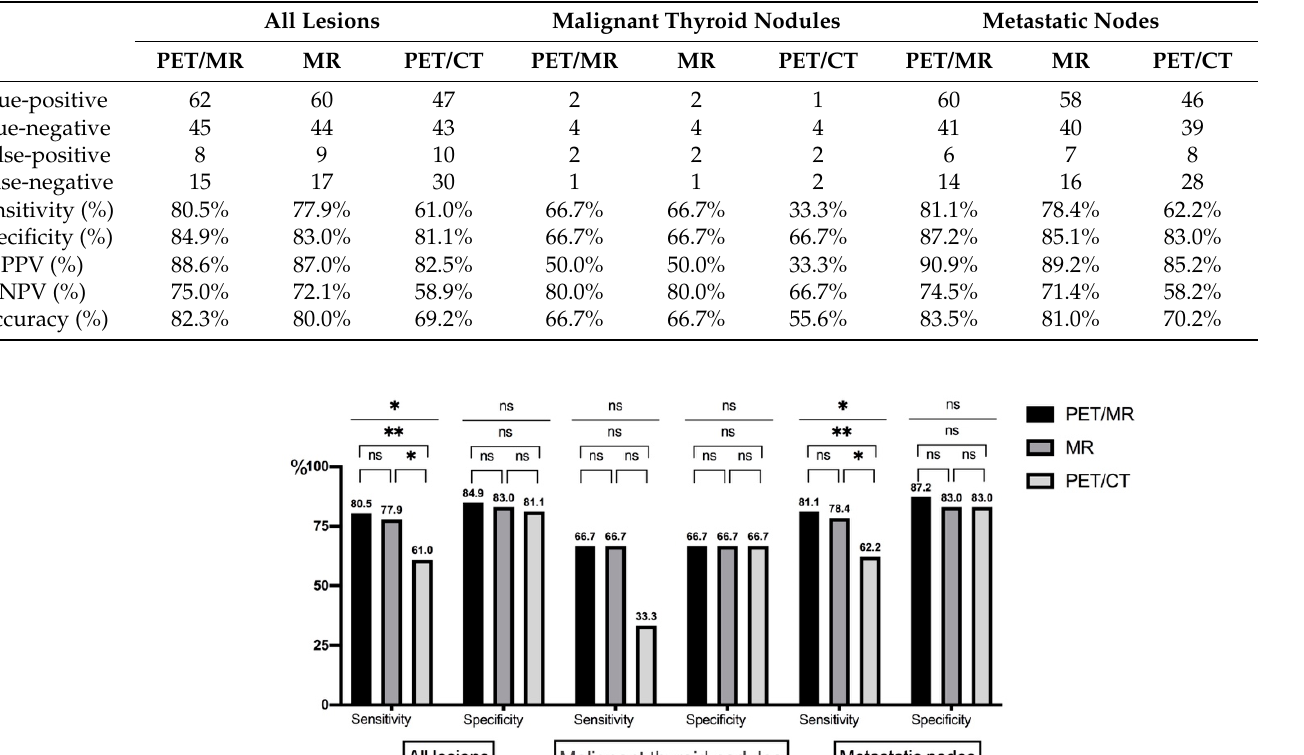
Table 3. Diagnostic performance of two modalities.